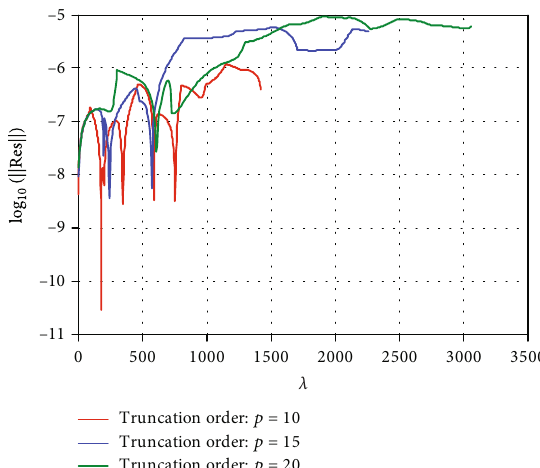
Figure 6: In fl uence of the truncation order of the Taylor series on the residue vector: evolution of the Euclidian norm of residue vector with respect to the loading parameter for di ff erent truncation orders.